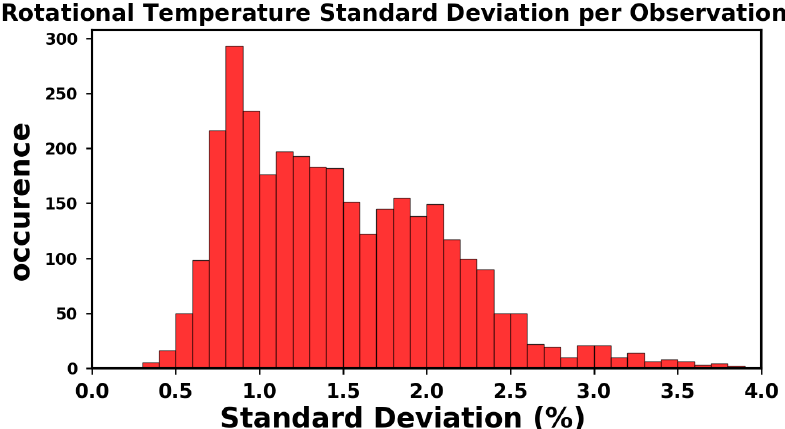
Figure A2. Standard deviation per observation of the OH ( 4 − 2 ) rotational temperature for the APOGEE data